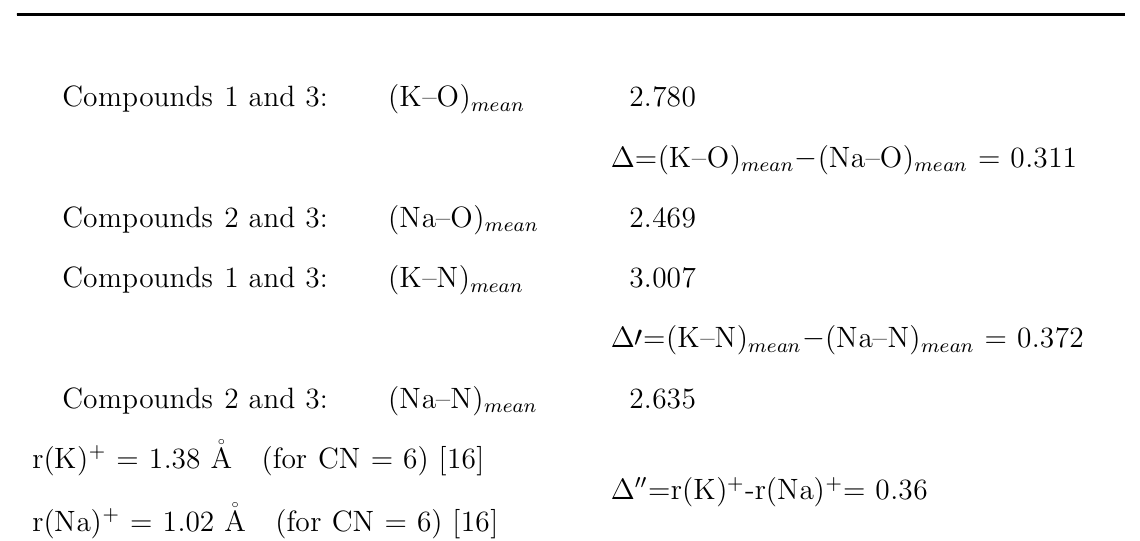
Table 2 (continue) Interatomic distances (¸A) involving the K + and Na + ions in the structures